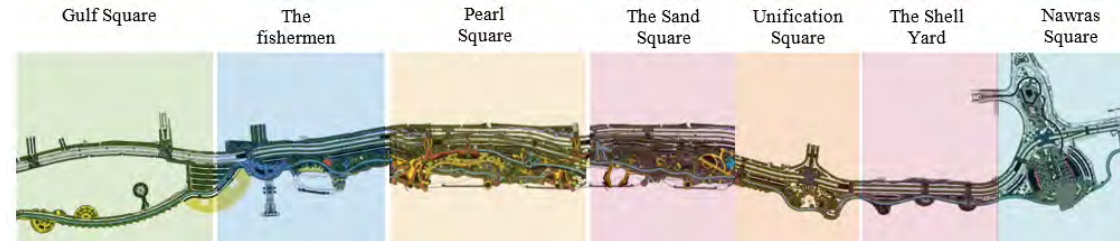
Figure 3. NJW Map illustrations theme parks locations and names Source: Jeddah Municipality, 2017